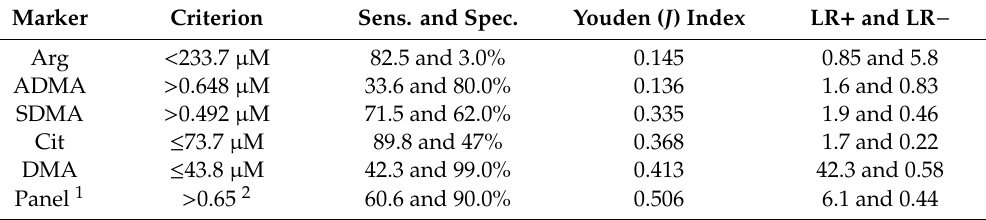
Table 9. Characteristics of L-arginine / NO pathway metabolites as di ff erential CRC